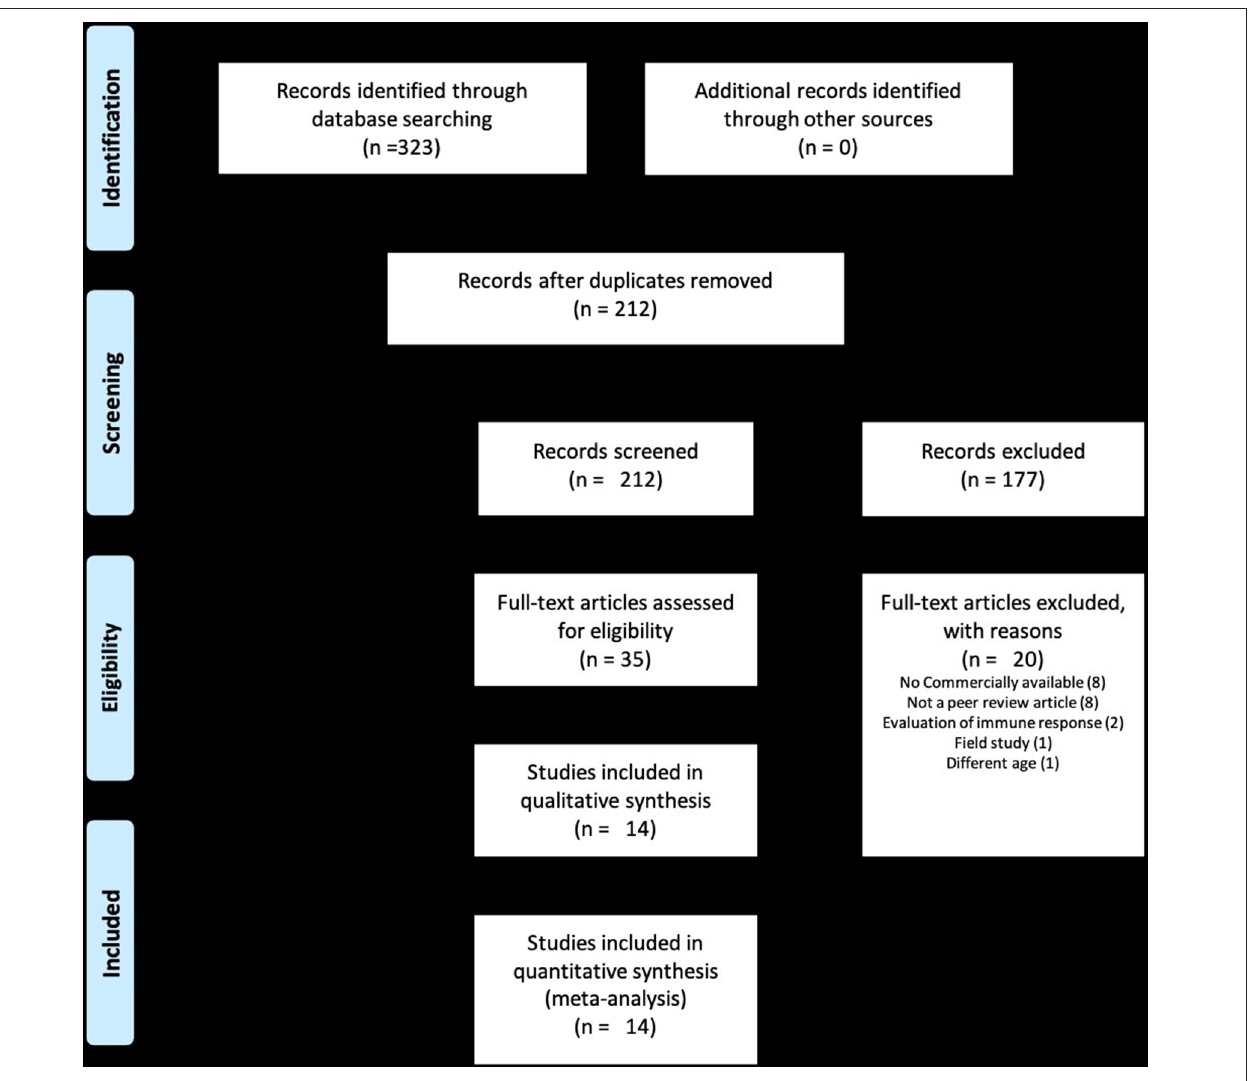
FIGURE 1 | PRISMA flow diagram of studies included in the